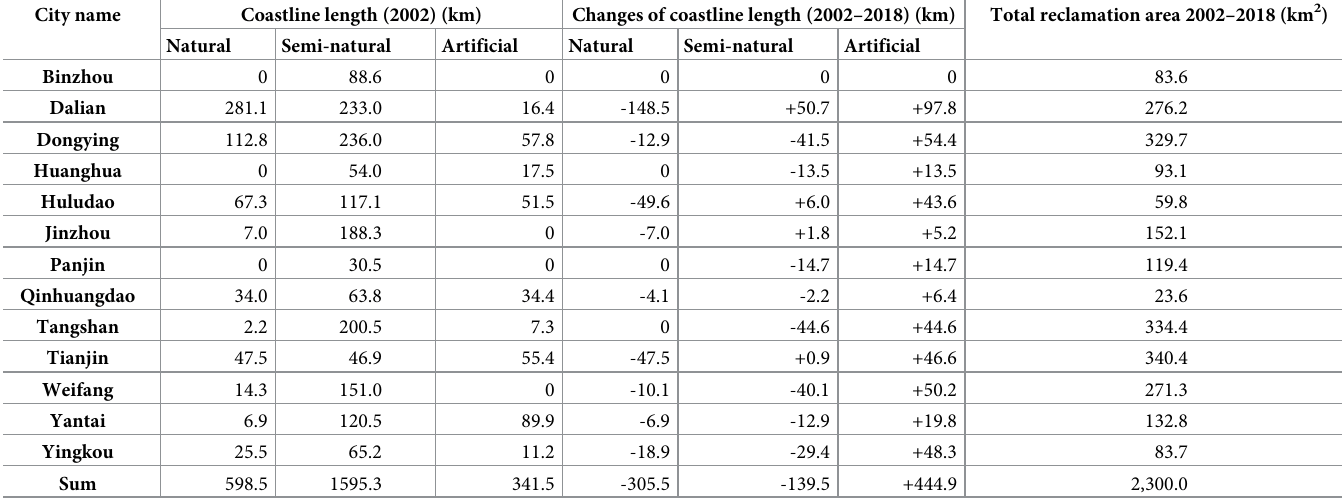
Table 2. Changes of different coastlines length and reclamation areas in the Bohai Sea during